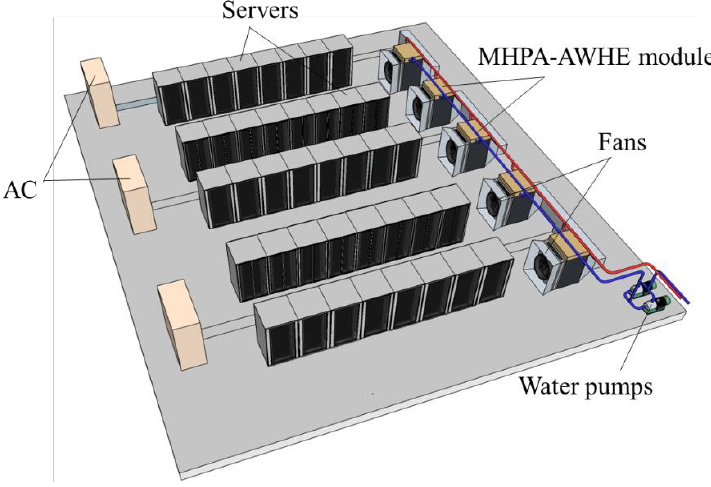
Figure 23. Architectural plan and perspective of the case study data center (DC).